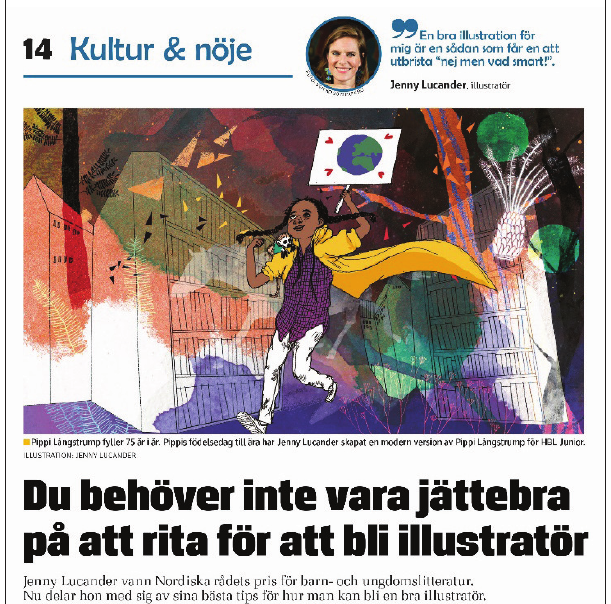
Figure 1. The Nordic blackness depicted in children’s journalism ( HBL Junior , 10 December 2020). to minority cultures; images of cross‐generational large families spending time in public parks; or images of transnational familial relationships that immigrants in Finland actively seek to maintain (see Chajed,